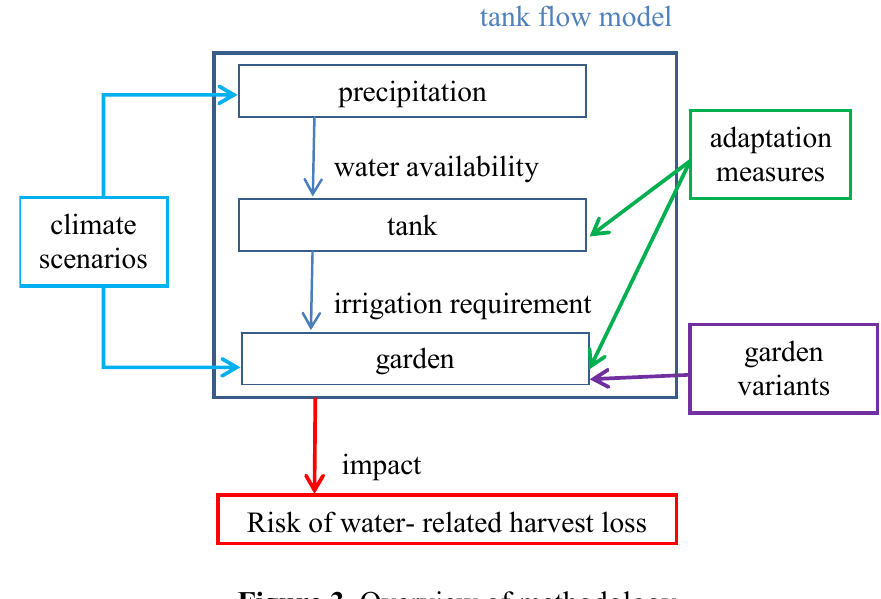
Figure 3. Overview of